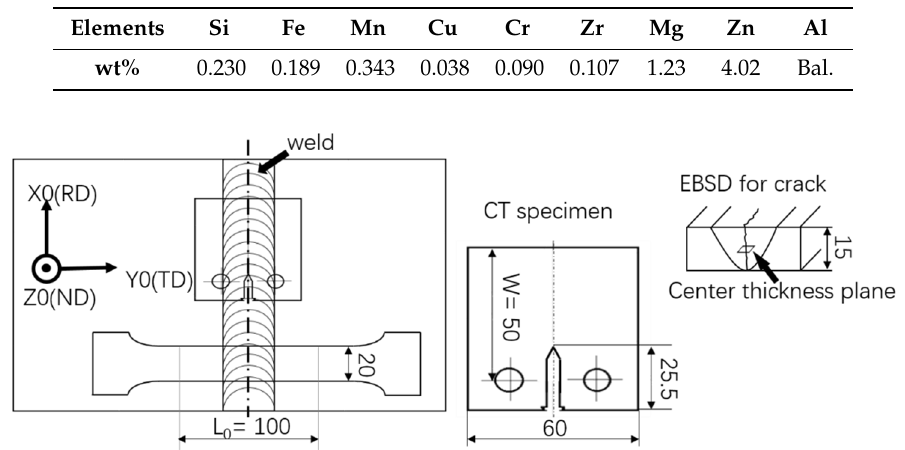
Table 1. Chemical composition of AA 7N01.